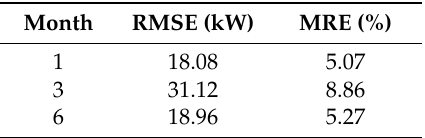
Table 1. Error of PV forecasting reference model.